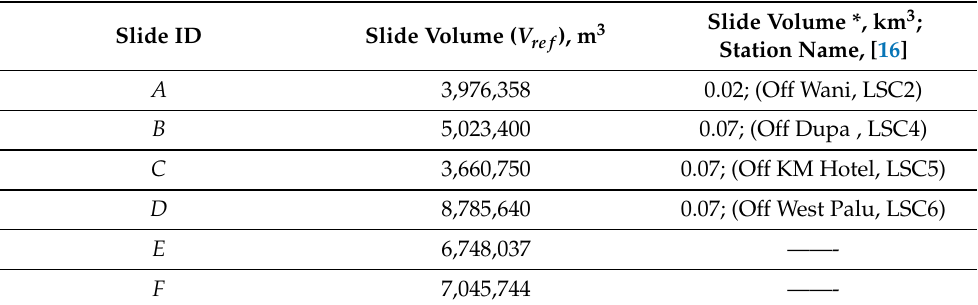
Table 1. The landslide volume V ref is determined from the topography in the observed subsidence location [45] smoothly extended into the water